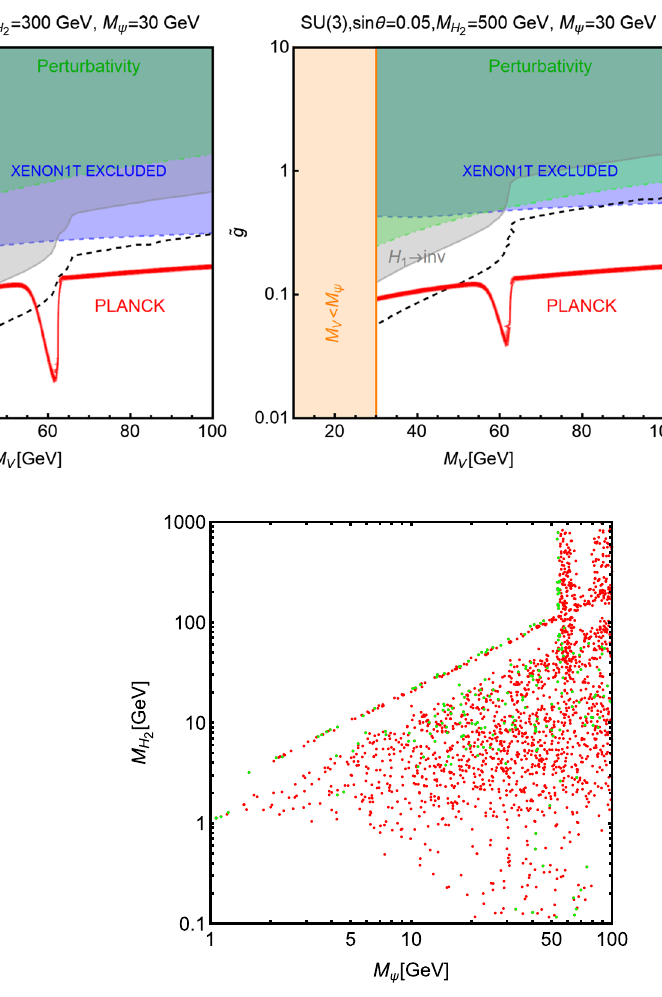
Fig. 24 Results of the parameter survey for the dark SU(3) model in the scenario of two component V /Ψ DM a scalar DM interacting with a mixed Higgs/scalar